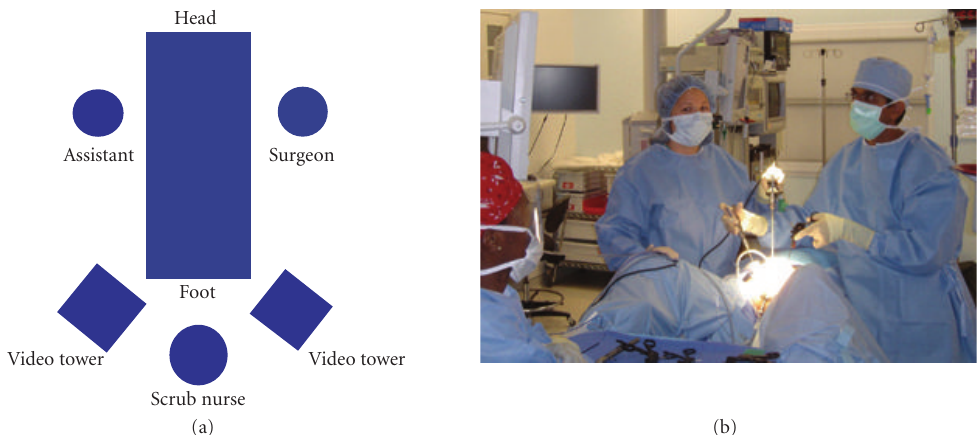
Figure 1: Patient is placed in dorsal lithotomy position with the surgeon standing to the patient’s left looking at a monitor over the right